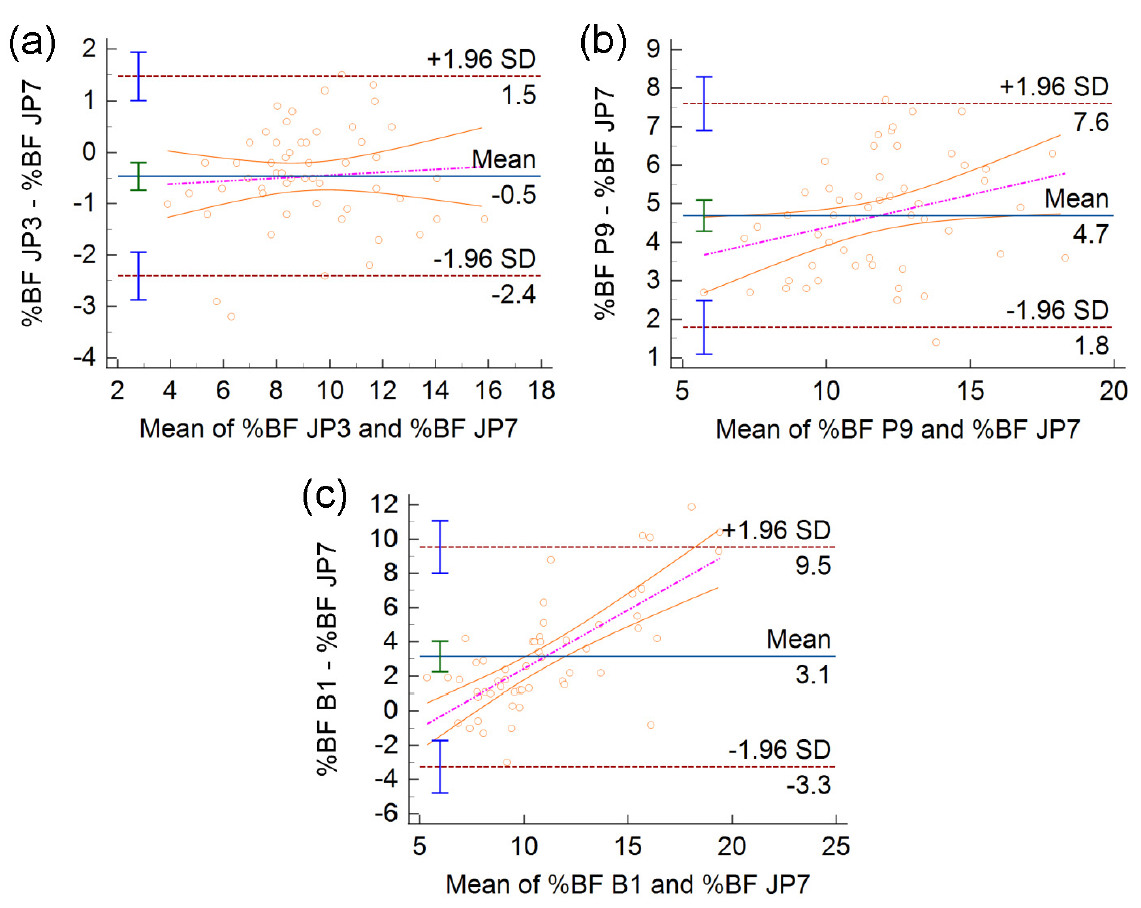
Figure 4. Bland–Altman plots of differences vs. means of %BF estimates provided by different prediction formulas. ( a ) JP3, ( b ) P9, and ( c ) B1 are compared to the reference formula, JP7. In each plot, the solid horizontal line depicts the mean of the differences, whereas dashed horizontal lines represent the upper limit of agreement (ULA = Mean + 1.96 SD) and the lower limit of agreement (LLA = Mean − 1.96 SD); here, SD stands for the standard deviation of the differences. The error bar displayed on each horizontal line represents the 95% CI of the corresponding quantity. The dashed– dotted linear regression line, sandwiched between its 95% CI curves, is indicative of proportional bias whenever its slope is significantly different from